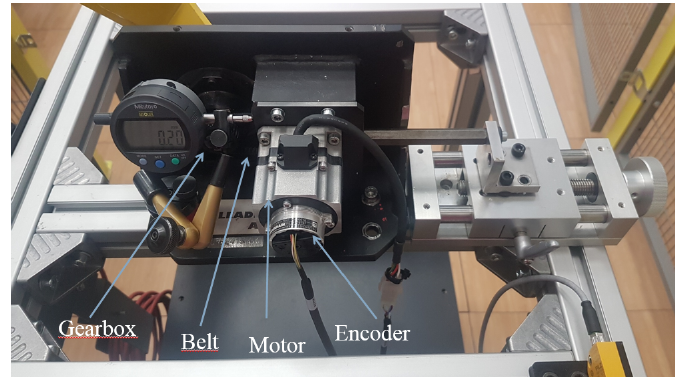
Figure 3. RobotBox